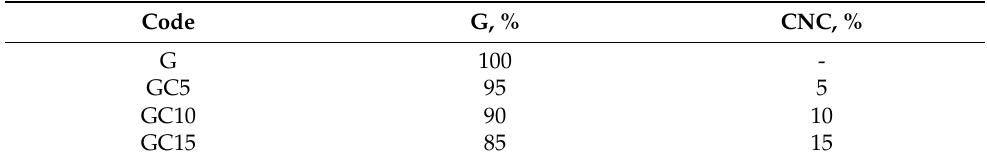
Table 1. Sample codes and